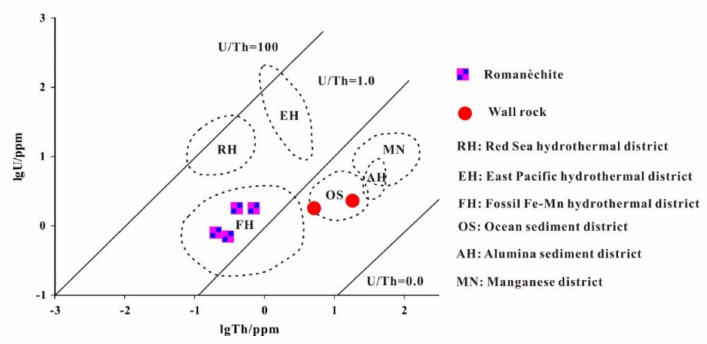
Figure 13. Trace element characteristics of the Sanbao Mn–Ag ore